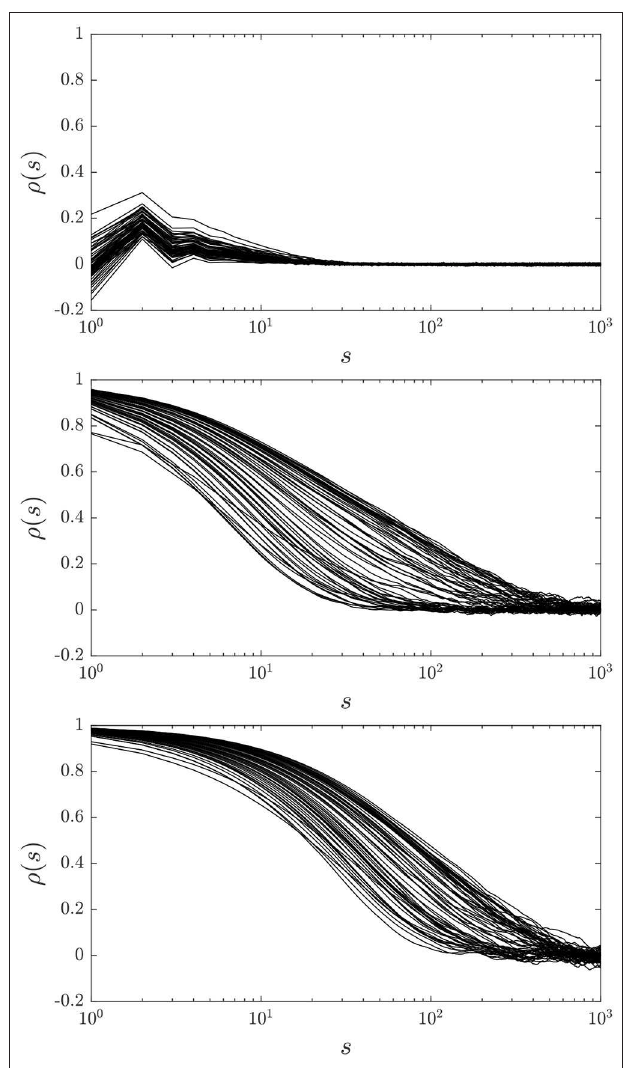
FIGURE 5 | Autocorrelation functions for q j , j A A 1 (top) , A =